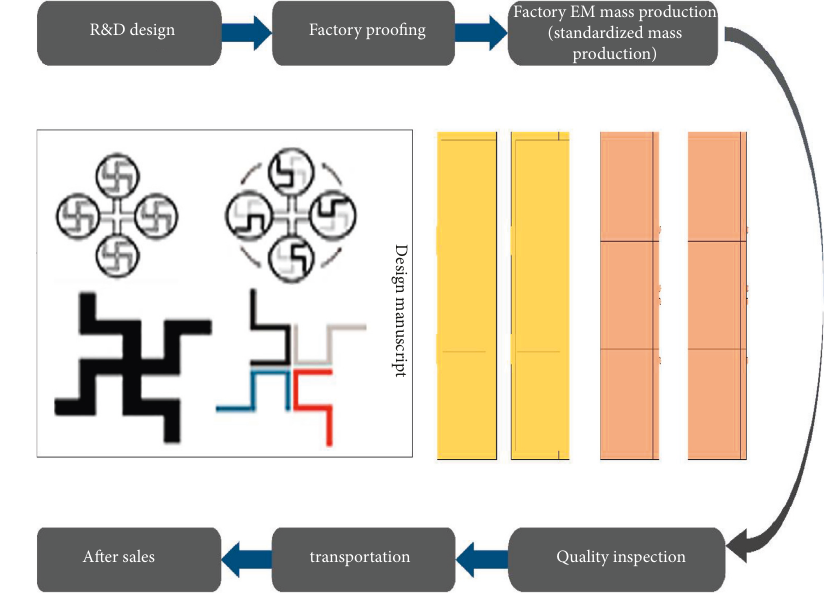
Figure 1: Production flow chart of custom Table 1: Traditional swastika pattern types.